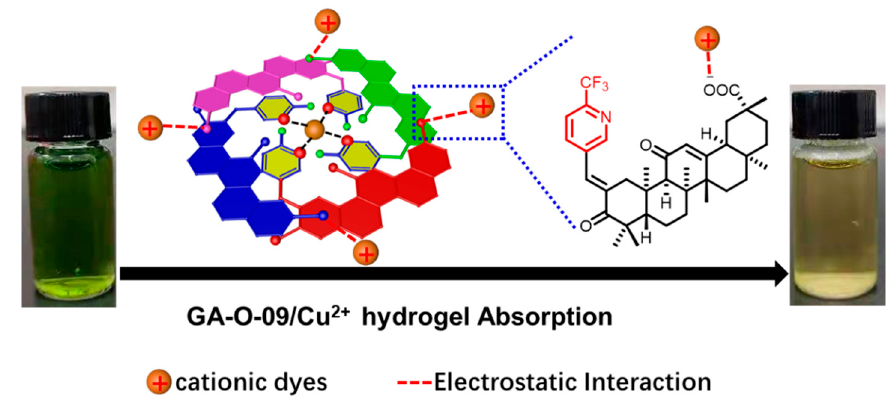
Figure 6. The possible mechanism of GA-O-09/Cu 2+ gel for cationic dyes removal.